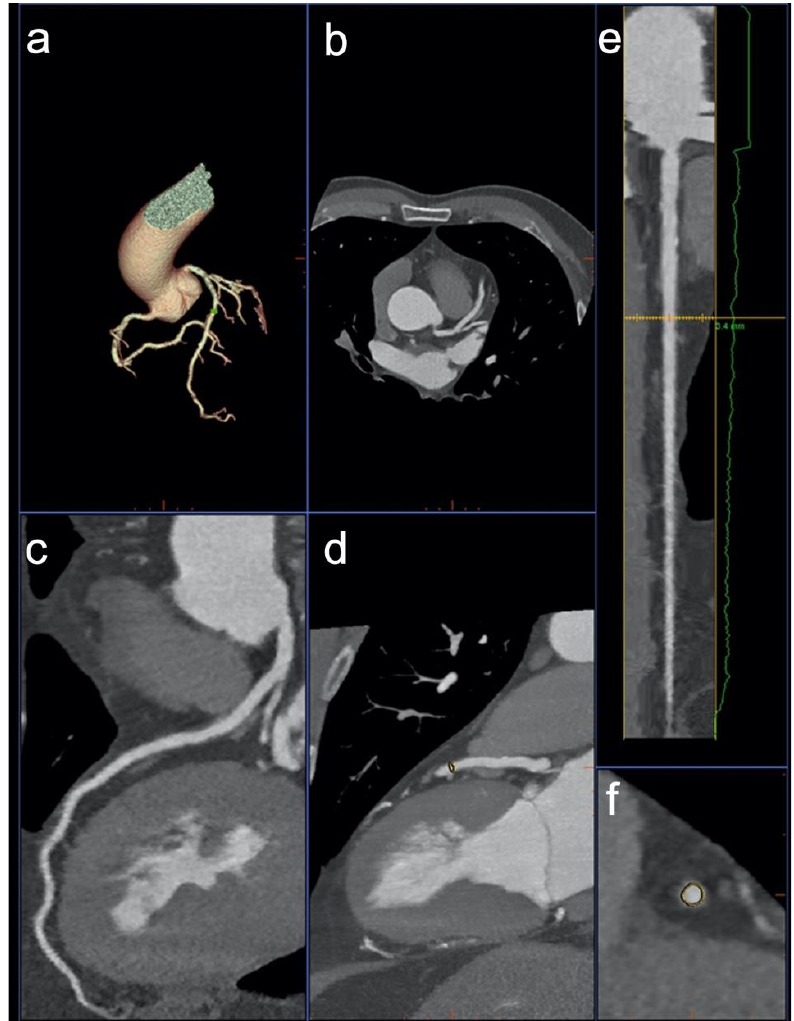
Figure 1. Software 1 showing a VR of the coronary artery tree ( a ), axial images ( b ), curved multiplanar reformation (cMPR, c ), and maximum intensity projection ( d ) of the LAD. Additionally, the software generates a stretched cMPR along the centerline ( e ) and axial sections of the vessel lumen ( f ).